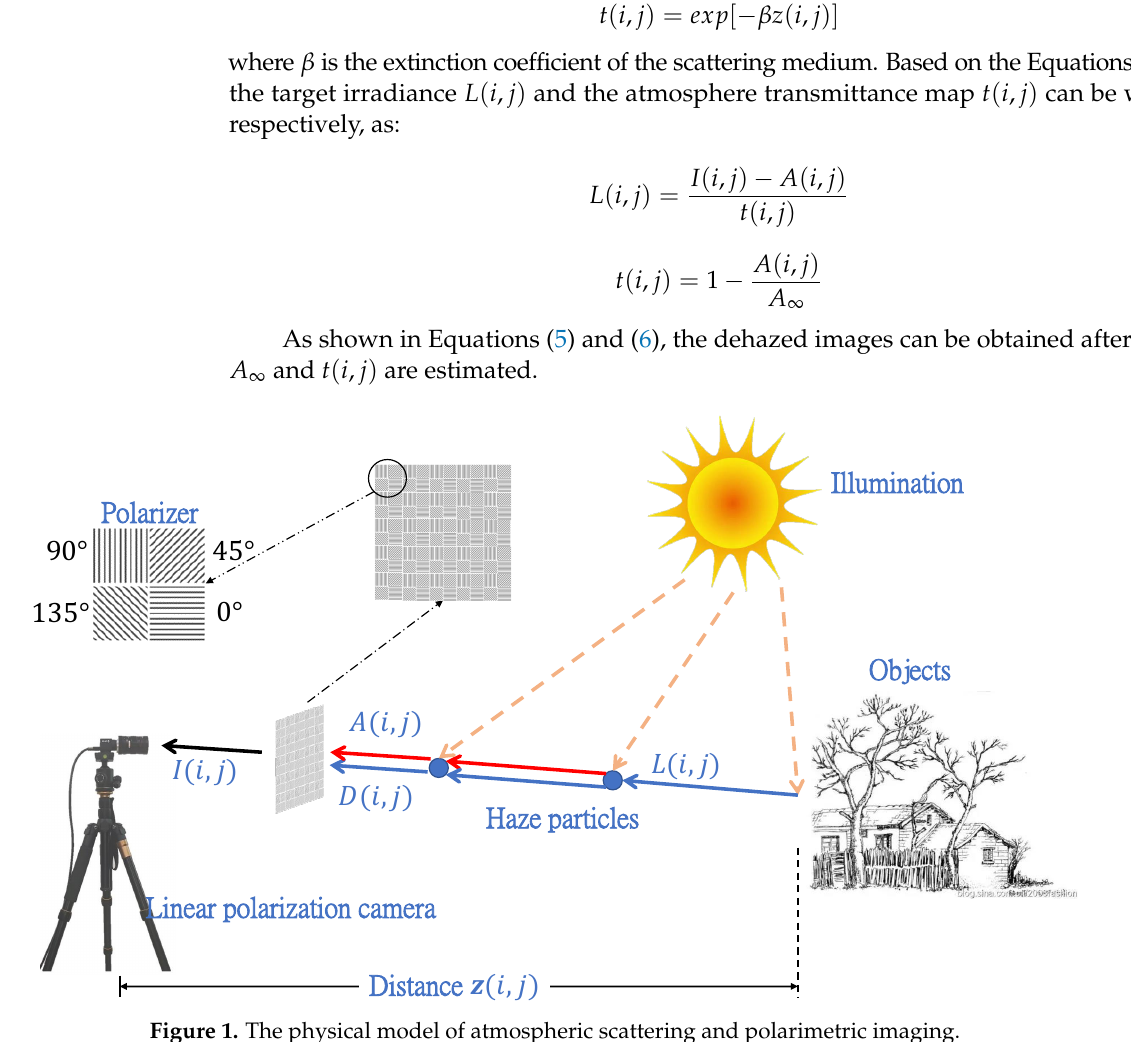
Figure 1. The physical model of atmospheric scattering and polarimetric